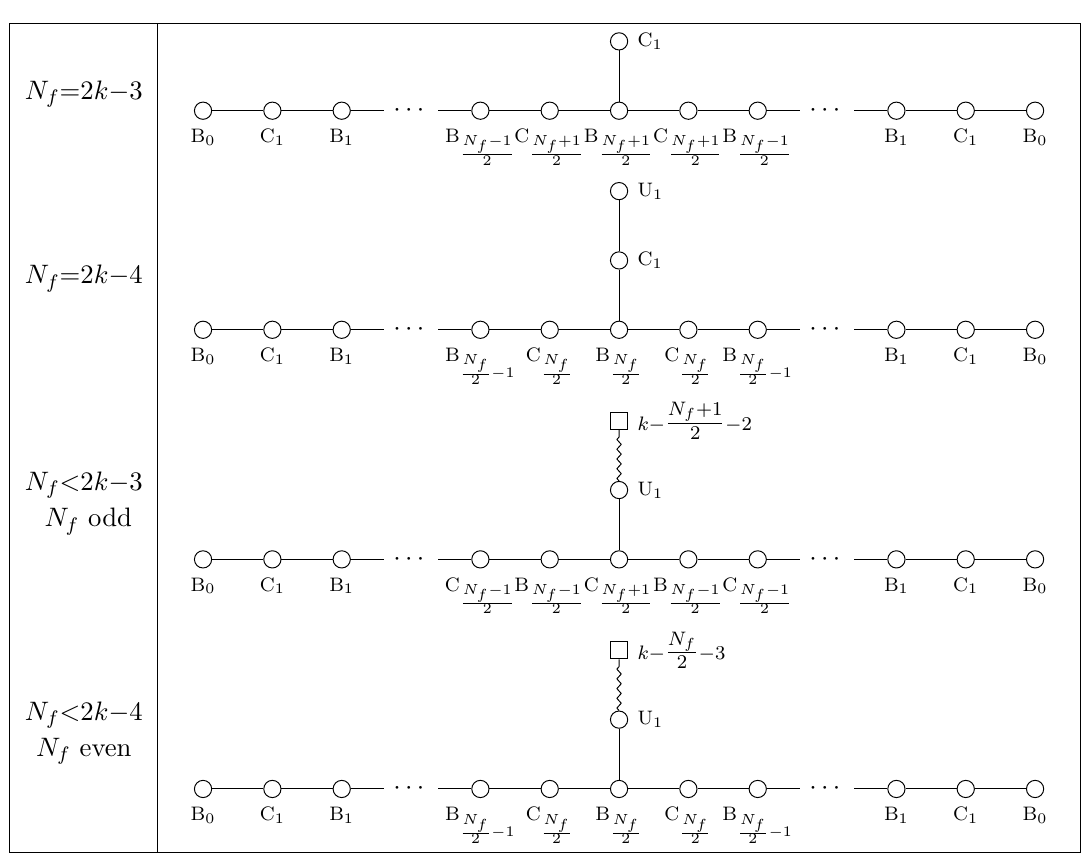
Table 11 . In(cid:12)nite coupling Higgs branches for O(2 k ) theories with N f (cid:13)avours. The moduli space dimensions correctly match the increase due to the new Higgs branch directions at in(cid:12)nite coupling [10] compared to (cid:12)nite coupling of table